Question: Summarize what this figure shows in one sentence.
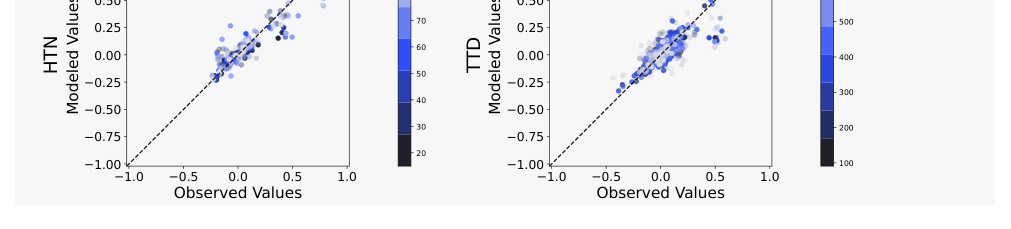
Answer: Goodness of fit for cross correlations in the General Medicine therapeutic area, with the indication for a given plot indicated by abbreviation on the left axis. All plots report on the principle cohort identified in Table 8. Cross-correlations between all change from baseline longitudinal outcomes are evaluated at discrete time bins indicated by the color bar for both the data and the digital twins. As the twins should represent the data well, we ideally expect these cross-correlations to all lie on the dotted diagonal line.